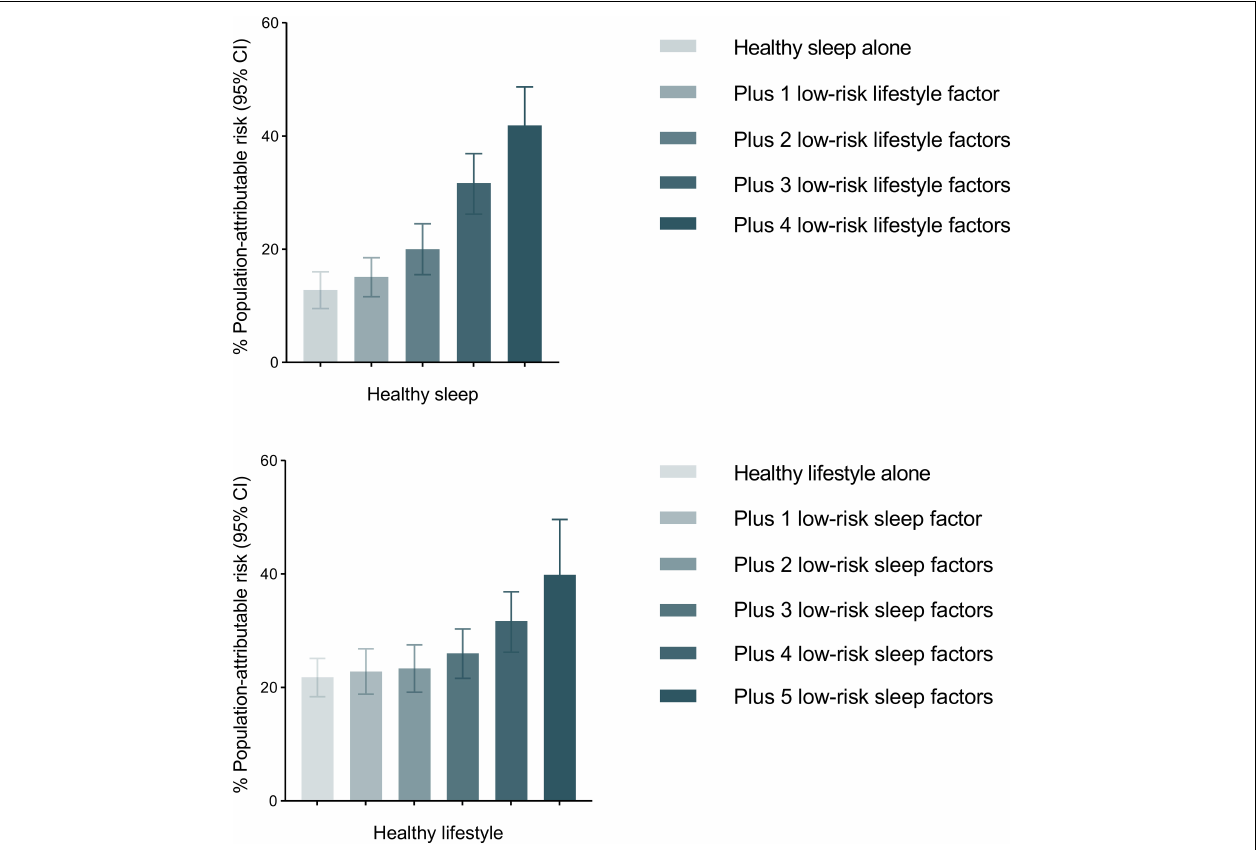
FIGURE 3 | PAR estimates for hypertension incidence associated with sleep scores and lifestyle scores. PARs and 95% CIs were calculated adjusting for age, sex, ethnicity, education, Townsend deprivation index, household income, baseline mean arterial pressure, alcohol consumption status, family history of hypertension, baseline cardiovascular disease, diabetes, chronic kidney disease, and cancer; Healthy sleep is defined as healthy sleep score ≥ 4; Healthy lifestyle is defined as healthy lifestyle score ≥